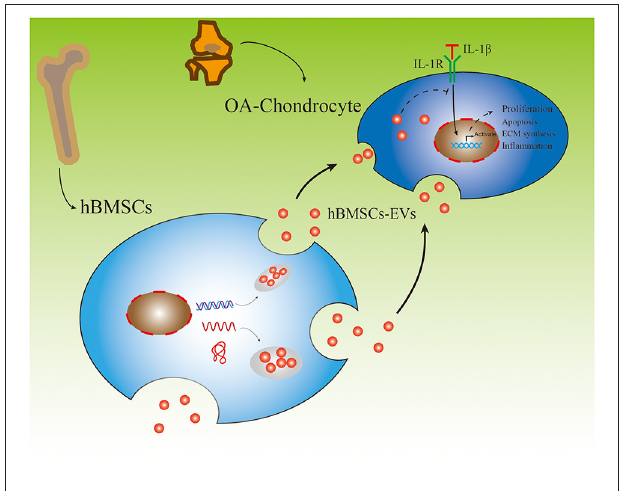
FIGURE 1 | Experimental outline of responses of IL-1 β -induced osteoarthritic chondrocytes (OA-CH) treated with hBMSC-derived EVs (hBMSC-EVs).